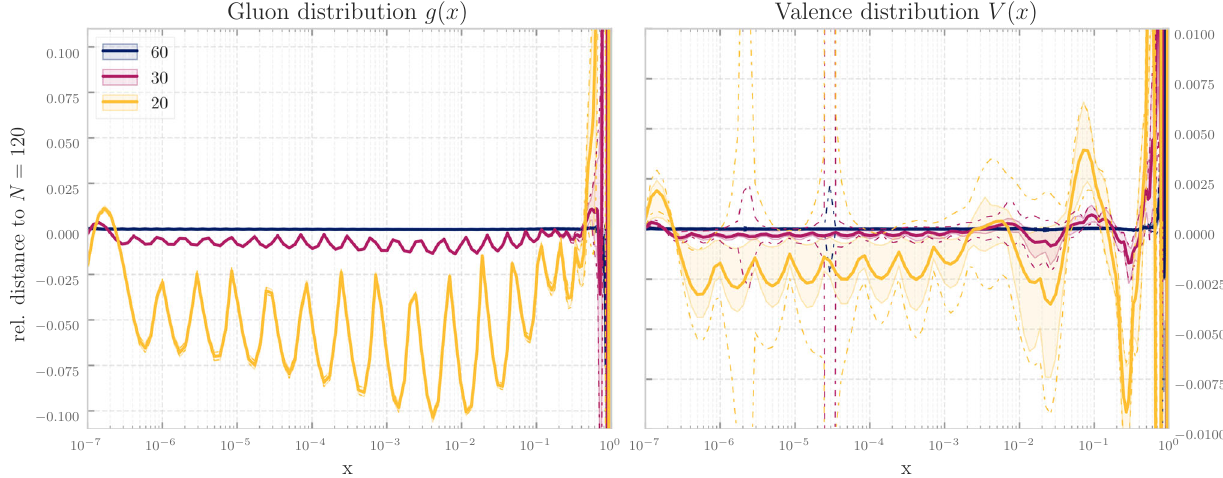
Fig. 5 Relative differences between the outcome of NNLO QCD evolution as implemented in EKO with 20, 30, and 60 points to 120 interpolation points respectively